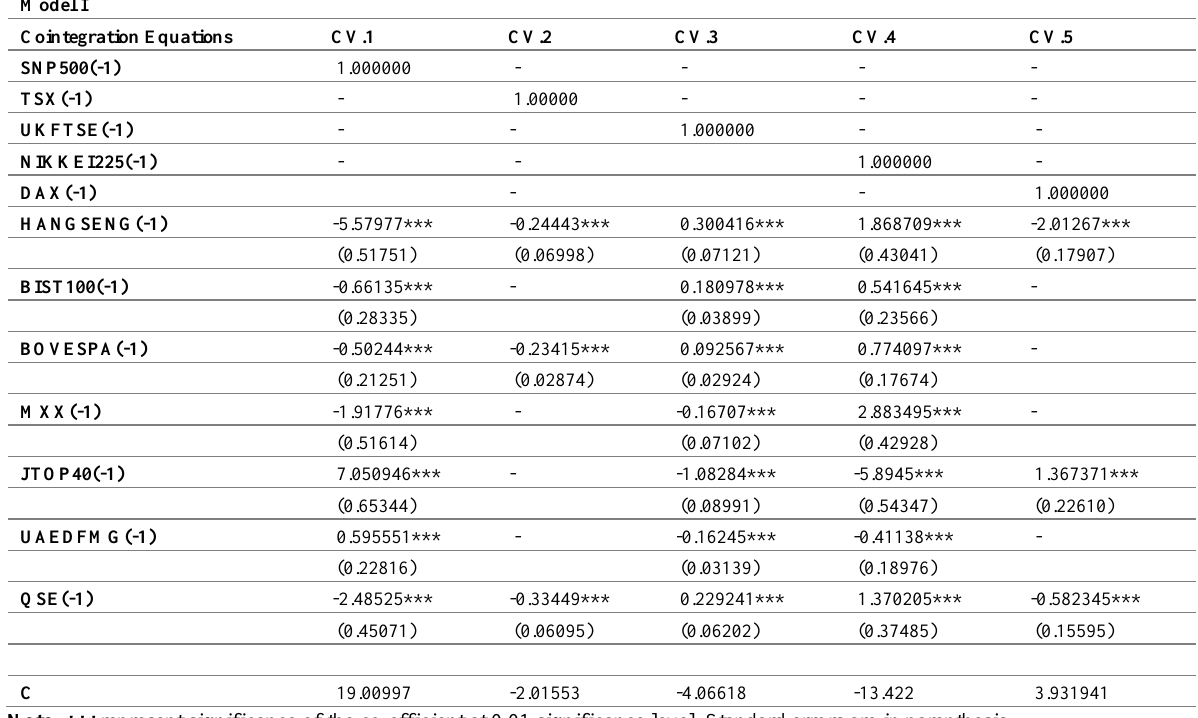
Table 6: Normalized Cointegration